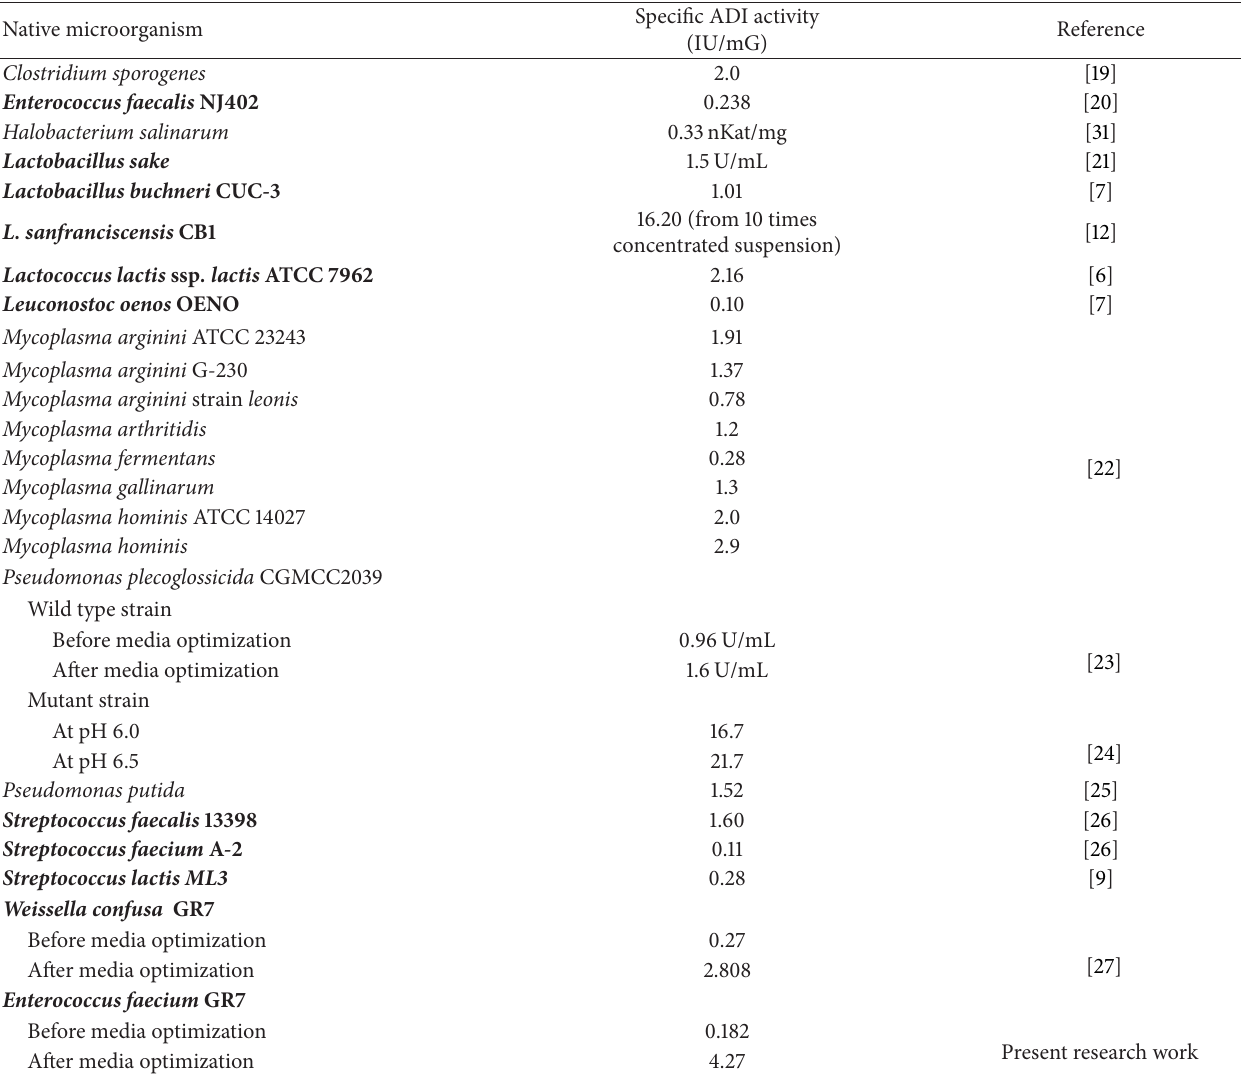
Table 7: Specific ADI activity in different